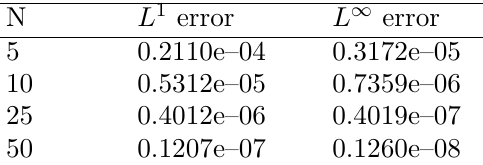
Table 2. L 1 and L ∞ convergence re- sults at x = 0 . 5.